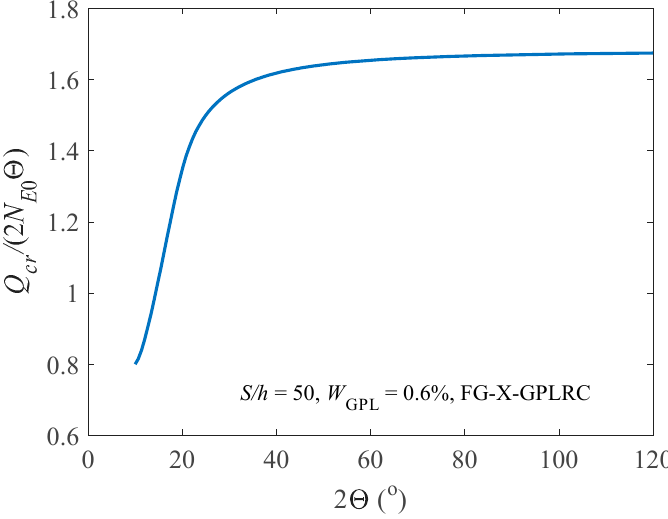
Figure 8. Effect of arch’s central angle on buckling loads of the FG-X-GPLRC arch. Figure 8. E ff ect of arch’s central angle on buckling loads of the FG-X-GPLRC